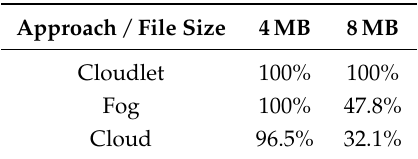
Table 1. Successful transmissions of 4 MB and 8MB